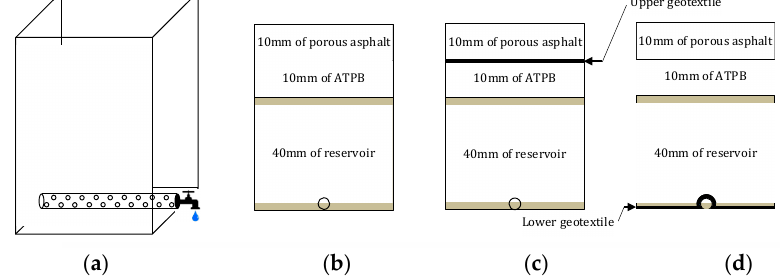
Figure 1. ( a ) Test rig for paving PA system model; ( b ) Simplified schematic cross section of a PA system without a geotextile; ( c ) Simplified schematic cross section of a PA system with a geotextile layer at the upper level; and, ( d ) Simplified schematic cross section of a PA system with a geotextile layer at the lower level.